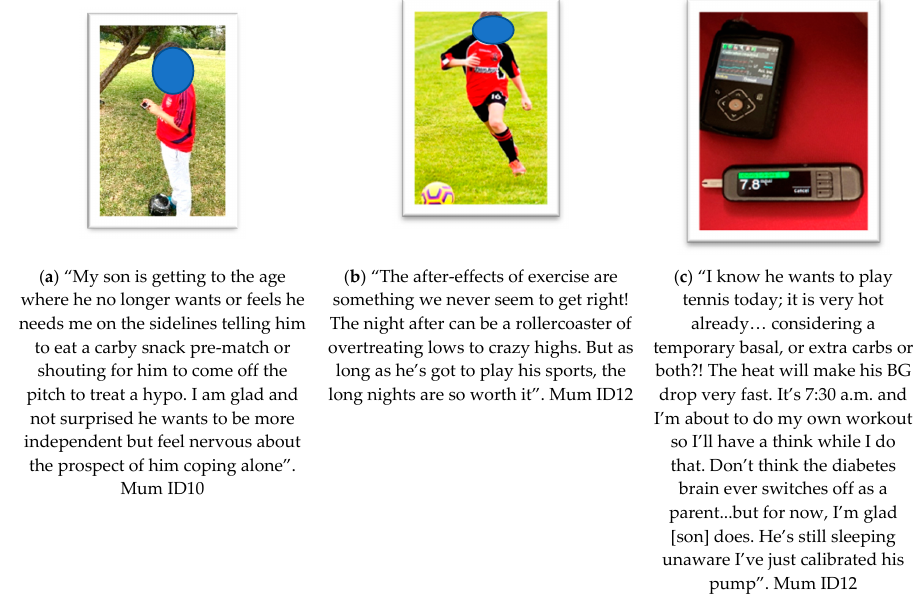
Figure 3. Photovoice submissions representing theme 2— Complexity & difficulty , showing data from interpreted as the following sub-themes: ( a ) transitions from parent; ( b ) uncertainty & PA-induced hypos; ( c ) parental burden in facilitation. Int. J. Environ. Res. Public Health 2022 , 19 , x FOR PEER REVIEW